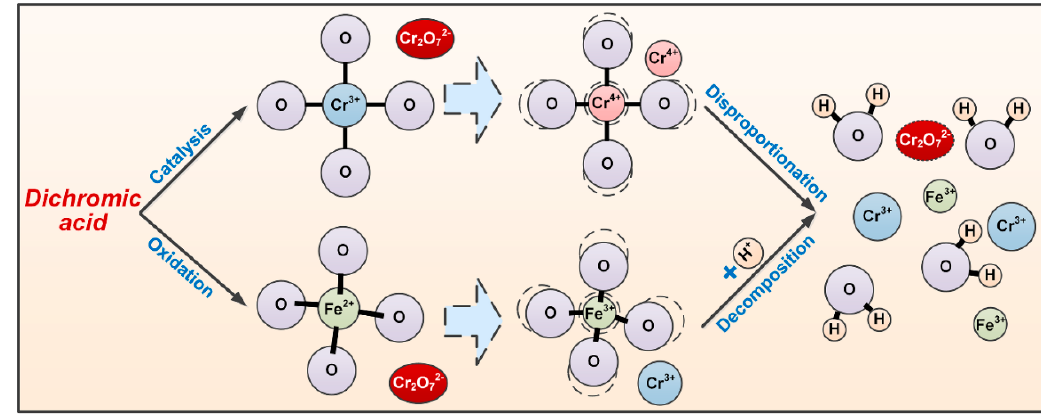
Figure 6. Illustration of the effects of dichromic acid on chromite decomposition.